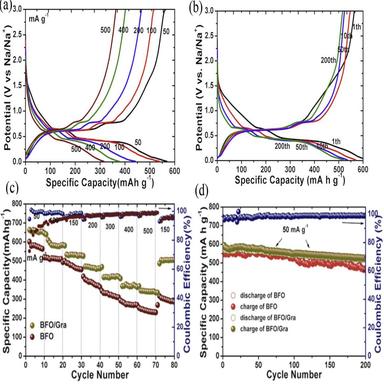
(a) Cycle-Voltammetry (CV) curves of the BFO electrode for the first five cycles. (b) Impedance spectra of the bare BFO and BFO/Gra electrode.